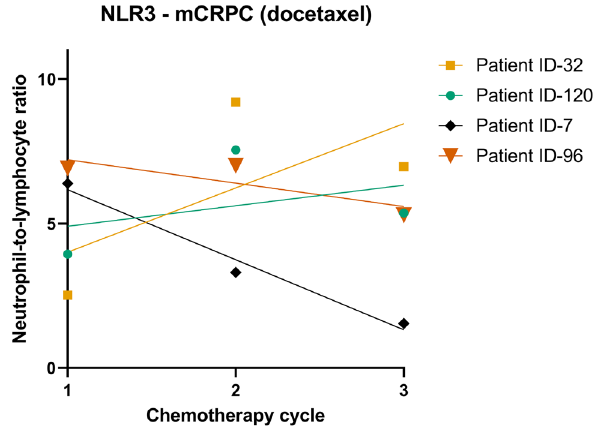
Fig. 1 NLR values of 4 patients of the mCRPC (docetaxel) cohort over their first 3 cycles and their respective NLR slope (NLR3). NLR3 NLR slope over the first 3 cycles, mCRPC meta- static castration-refractory prostate cancer, ID identifica- tion